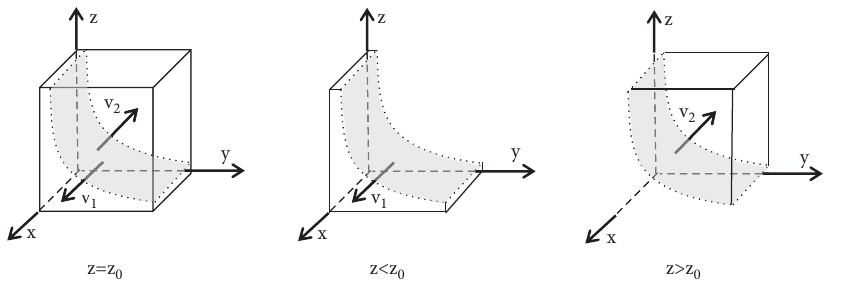
Figure 1: Phase diagram of government strategy